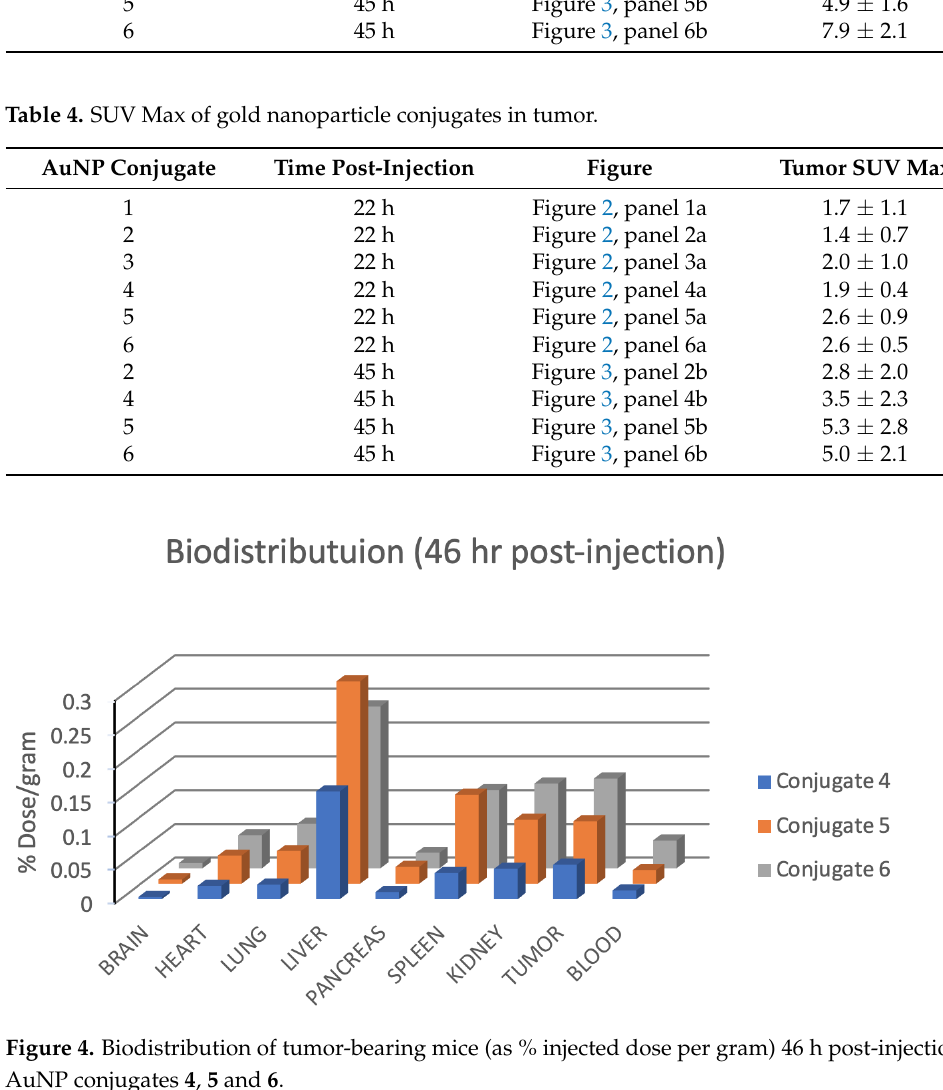
Figure 3. Representative whole-body coronal PET images of tumor-bearing mice at 45 hrs post-in- jection of PEG-MTX-AuNP conjugate 2 ( 2b ), MTX-RGD-AuNP conjugate 4 ( 4b ); Glu-RGD-AuNP